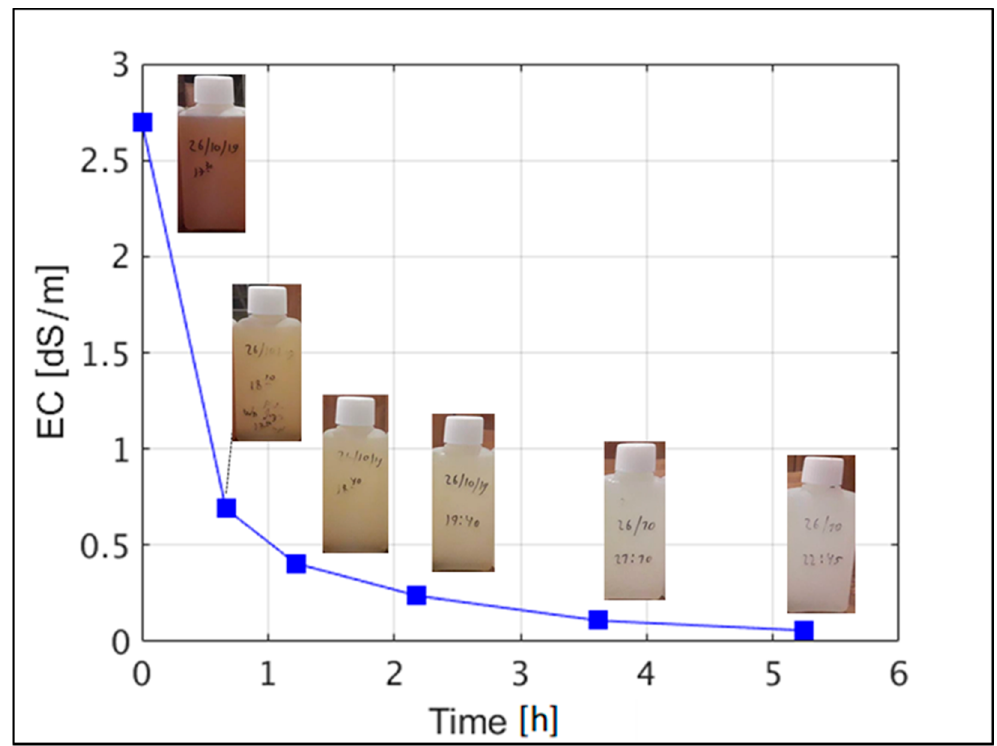
Figure 3. Measured EC in the water collected from roof #1 at the first flush of the season. Time is from onset of the rain event. The pictured bottles are of the collected water throughout the event to demonstrate the changes in water turbidity with time.